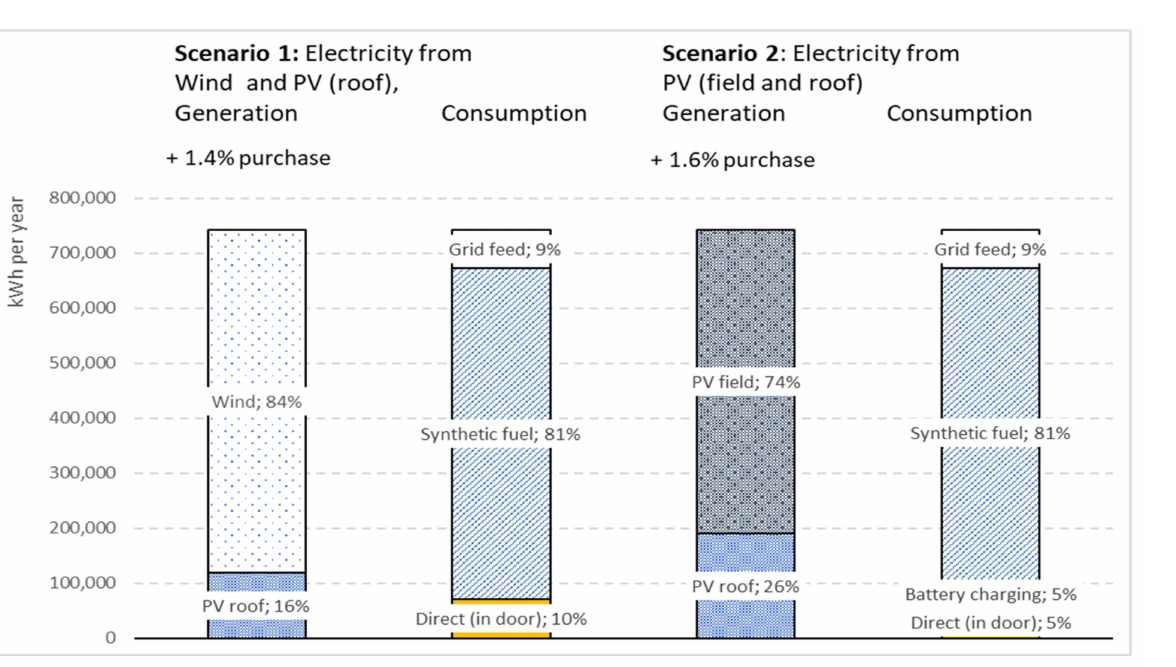
Figure 6. Annual electricity generation and comparison of the consumption of electricity generated (Scenario 1 and Scenario